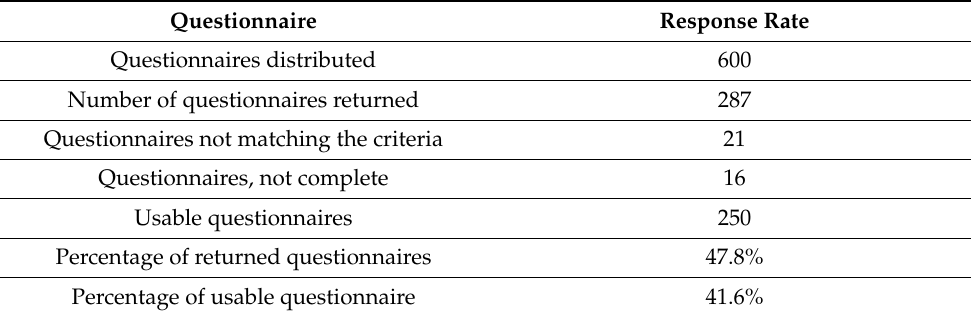
Table 1. Questionnaire distribution and response rate. Questionnaire Response Rate Questionnaires